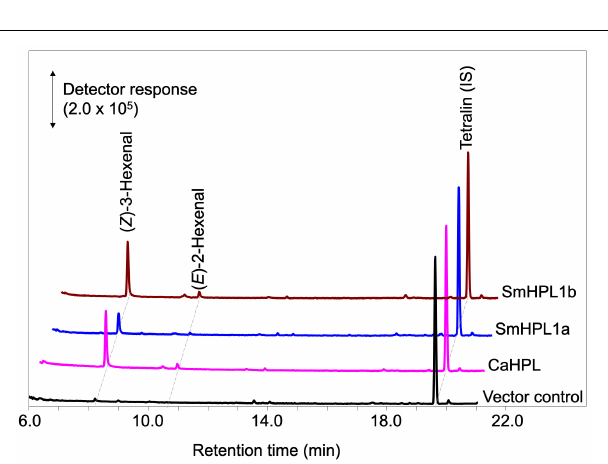
FIGURE 5 | GC-MS analyses of the volatile products formed by recombinant SmHPL1a (blue) and SmHPL1b (brown) from 13HPOT. As the positive control, volatile products formed by bell pepper HPL (CaHPL) from 13HPOT are also shown (magenta). The vector control was run with the membrane fraction of E. coli cells harboring pET15b